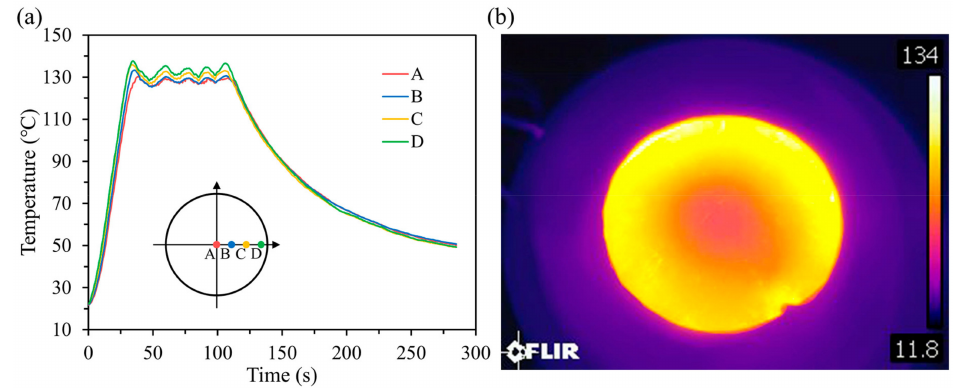
Figure 5. ( a ) Plot of measured temperature at di ff erent locations vs imprint time during a typical imprint process; and ( b ) infrared radiation (IR) thermal image of the nickel mold at one moment in the heating process (the unit for the axis in Figure 5b is ◦